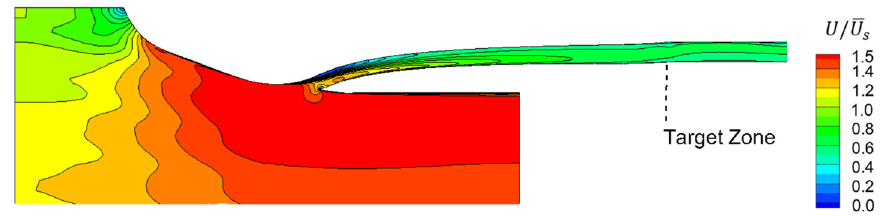
Figure 17. Design of optimal non-uniformity in DoE 1, a1b6c7.